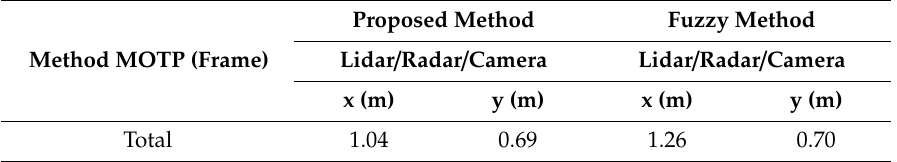
Table 7. Comparison of the results of the proposed method with fuzzy method in all